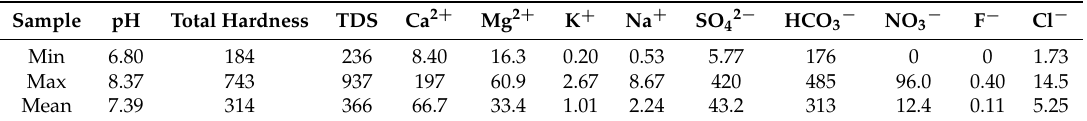
Table 2. Statistics of geochemical concentrations in groundwater samples collected from the studied dolomite aquifer between 2008 and 2012 (all concentrations in mg/L), including the pH, total hardness, total dissolved solids (TDS), cations (K + , Na + , Ca 2 + , Mg 2 + ), and anions (HCO 3 − , F − , Cl − , NO 3 − , SO 42 − ).